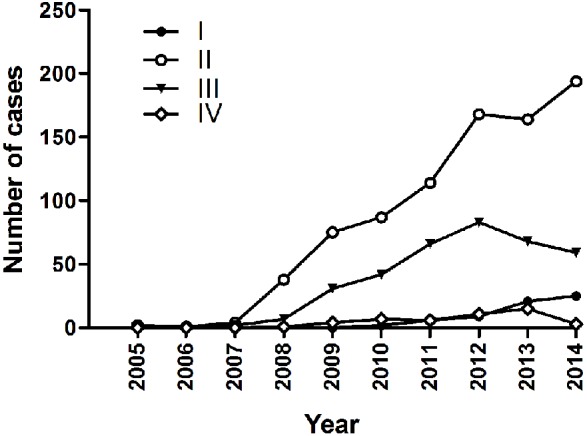
The change trend in increase of case number by Fuhrman grade from 2005 to 2014.In this figure, the X-axis represents the year from 2005 to 2014; the Y-axis represents number of the case. I: representing Fuhrman grade I; II: representing Fuhrman grade II; III: representing Fuhrman grade III; and IV: representing Fuhrman grade IV.